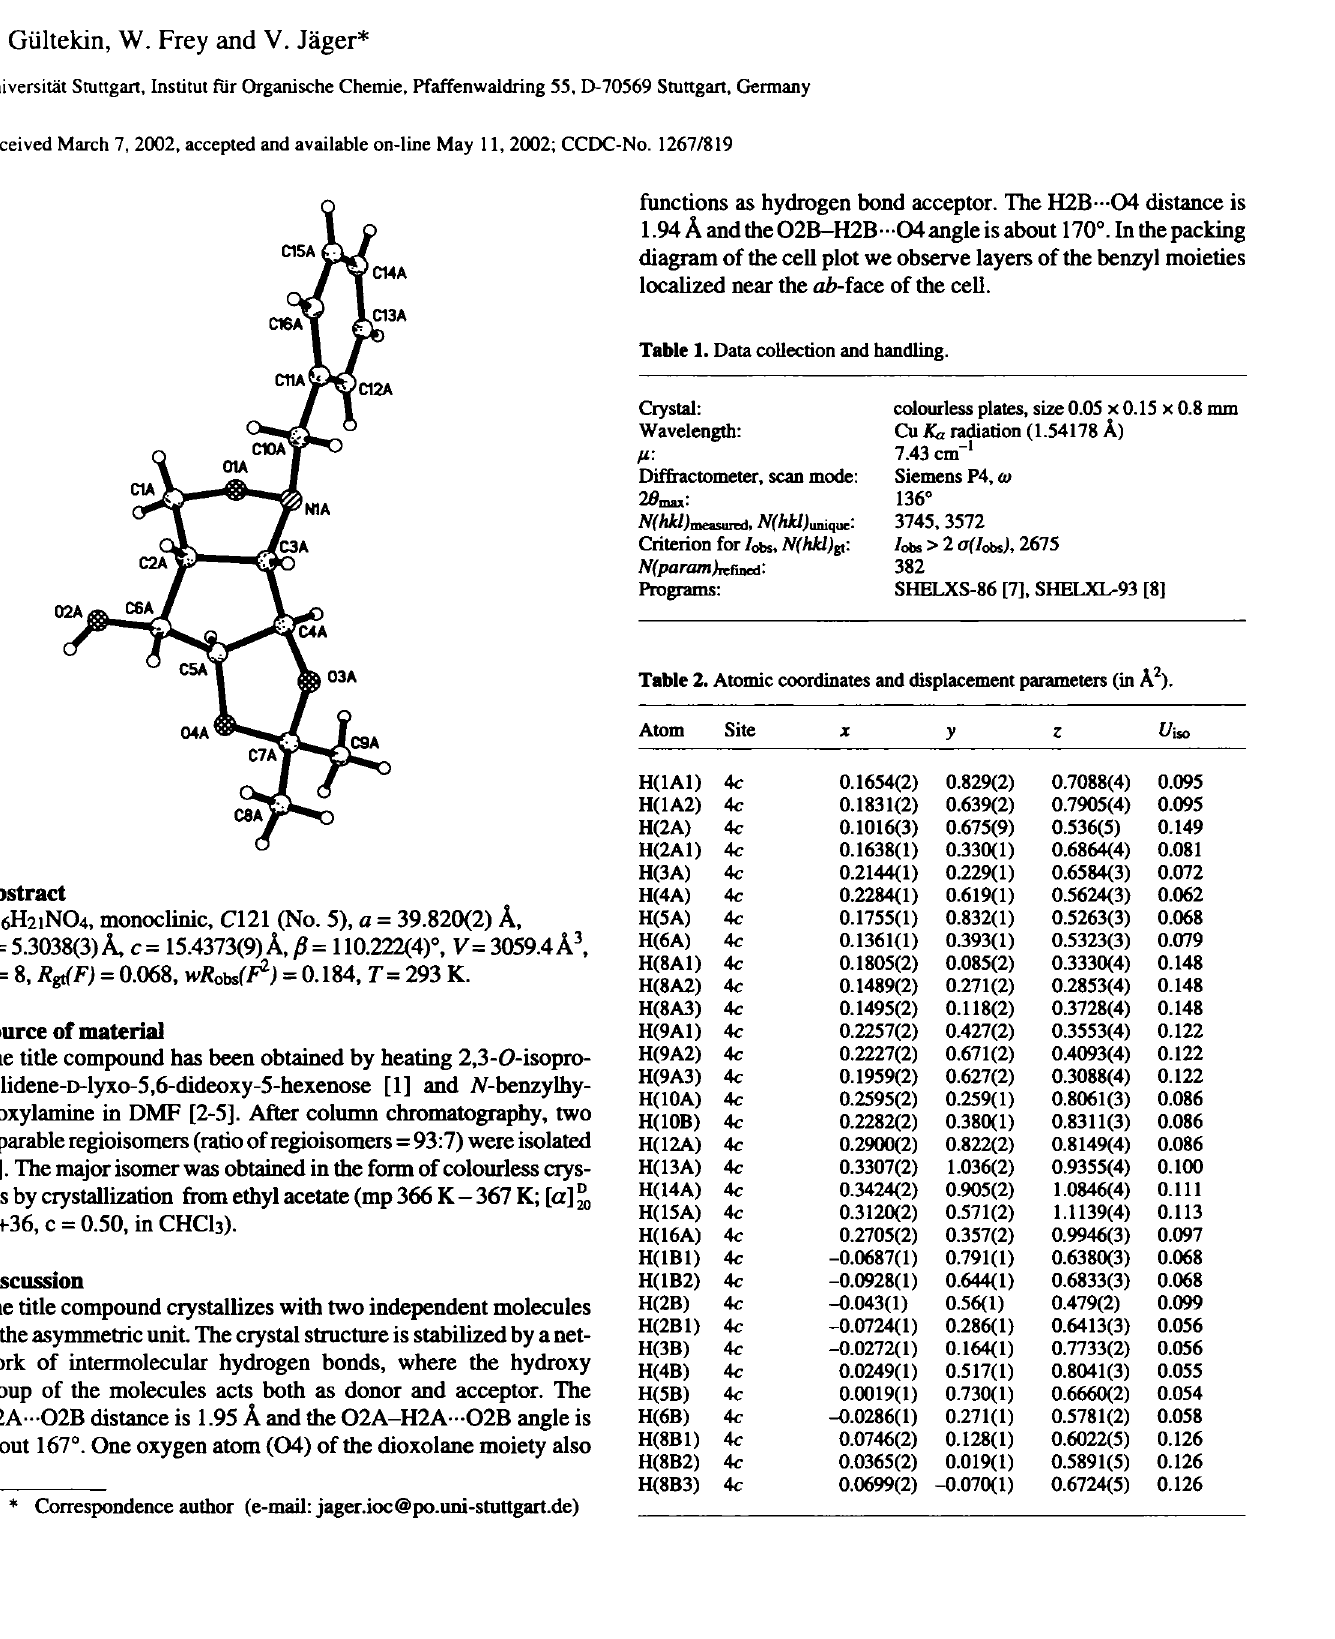
Table 2. Atomic coordinates and displacement parameters (in À 2